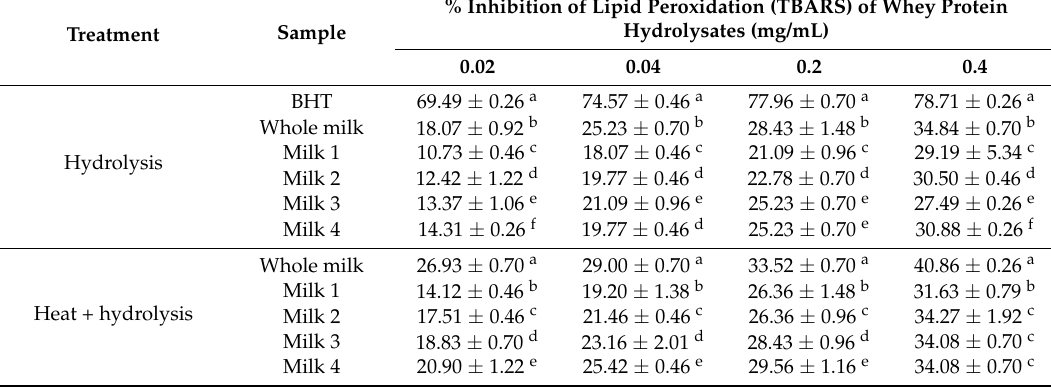
Table 2. Antioxidant activity of native and heated whey proteins hydrolysates obtained of whole cow milk and four commercial cow milks from